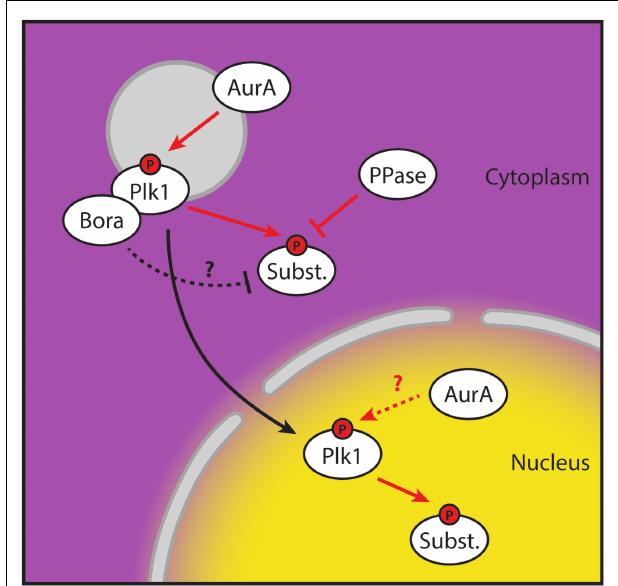
FIGURE 4 | Spatial separation of Plk1 phosphorylation and activity . Proposed model for Plk1 activation during G2. Plk1 binds to its co-factor Bora and is subsequently activated at the centrosome on T210 by Aurora A. Activity of the T210-phosphorylated Plk1 is inhibited in the cytoplasm, possibly by Bora or by phosphatase activity directed at its substrates. T210-phosphorylated Plk1 then translocates to the nucleus where the inhibitory factors of Plk1 activity are absent and Plk1 starts phosphorylating its substrates. The contribution of nuclear Aurora A is currently unclear. Yellow and purple indicate high and low levels of Plk1 substrate phosphorylation, respectively. Red arrows indicate phosphorylation events. The “P” indicates phosphorylation of